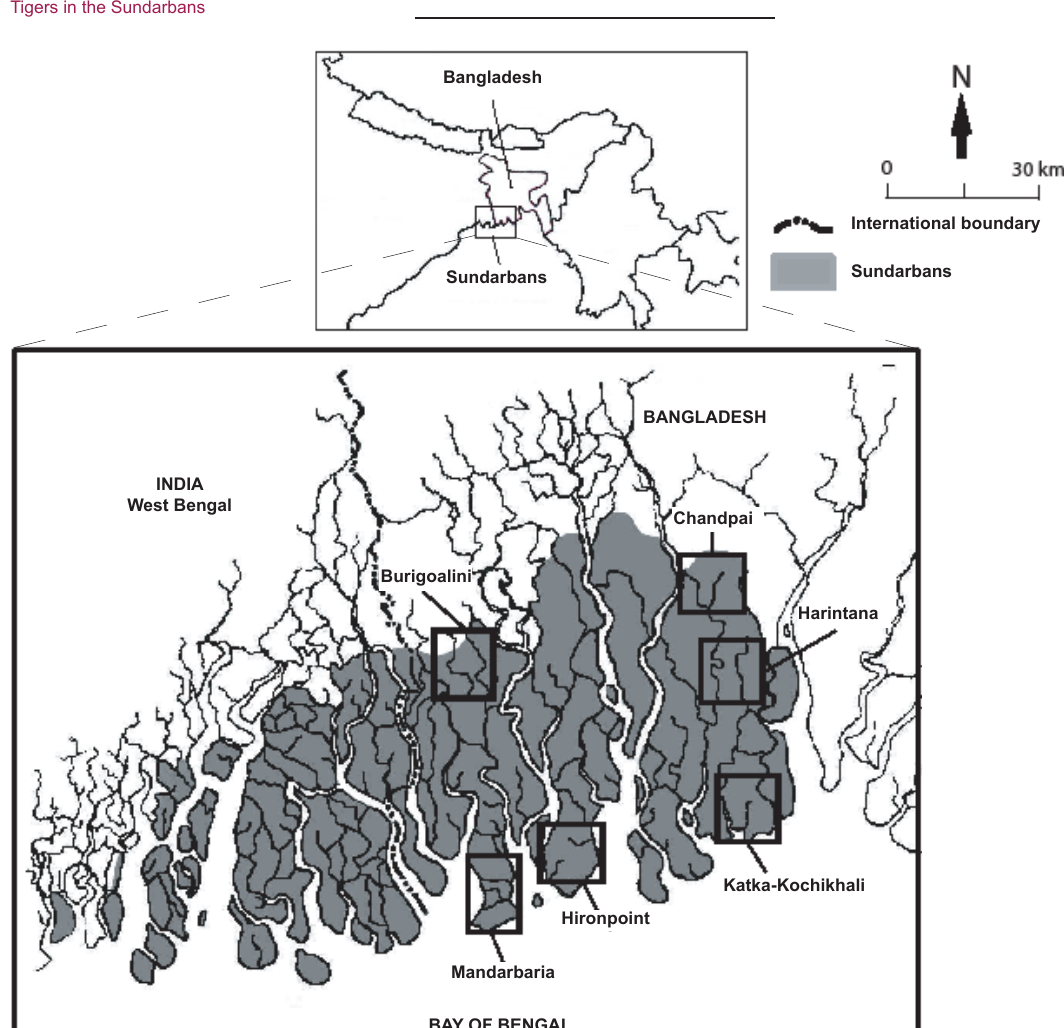
Image 1. The Sundarbans of Bangladesh and India showing six sites where the survey on tiger and prey densities was Table 1. Six sites in the Sundarbans where the surveys of tiger and prey densities were conducted (each survey site was approximately 170km 2 )